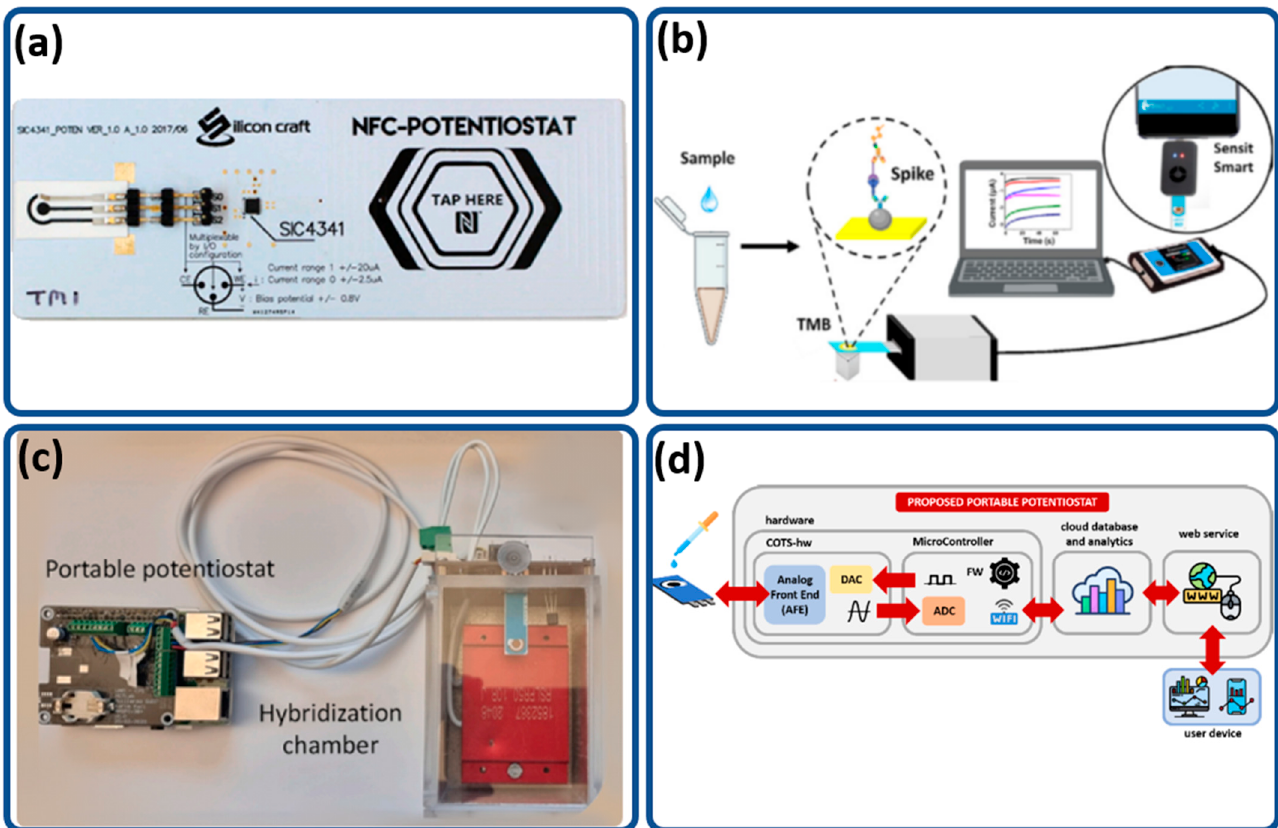
Figure 6. ( a ) SIC4341 circuit board diagram of a portable NFC potentiostat [87]. ( b ) PalmSens4 po- tentiostat used for SARS-CoV-2 detection [88]. ( c ) Portable potentiostat developed by Kaci et al. (2022) [23]. ( d ) Proposed potentiostat flow developed by Bianchi et al., n.d.